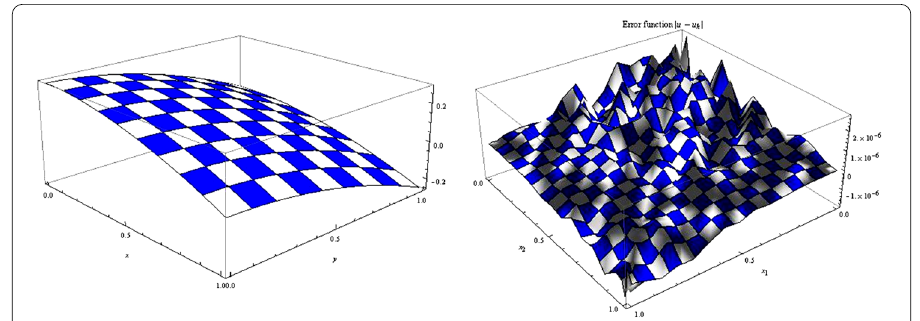
Figure 4 Graphs of the SMRPI solution and the error with h = 1/32 for Example 2